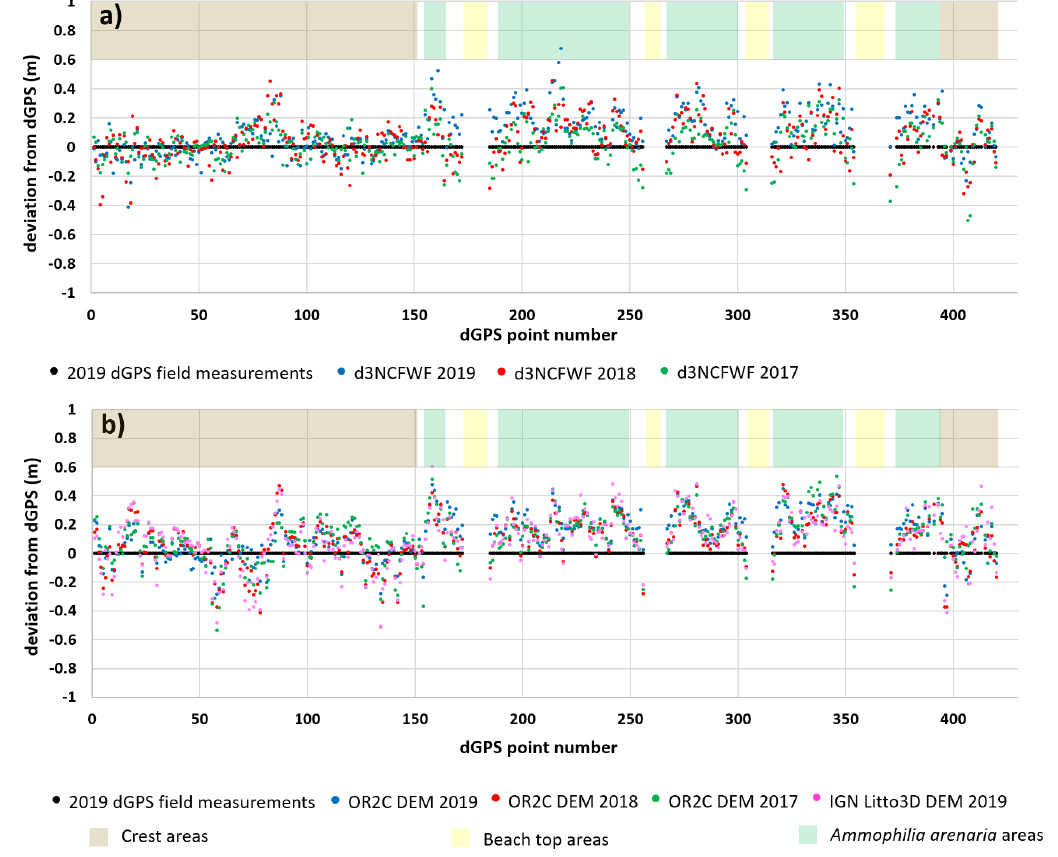
Figure 10. Deviation between the dGPS data and corrected data: ( a ) d3NCFWF’s first echo and ( b ) DTM data for 2017 ( green points ), 2018 ( red points ), and 2019 ( blue points ), as a function of the field sampling point number. Years’ and environments’ color codes are identical to Figure